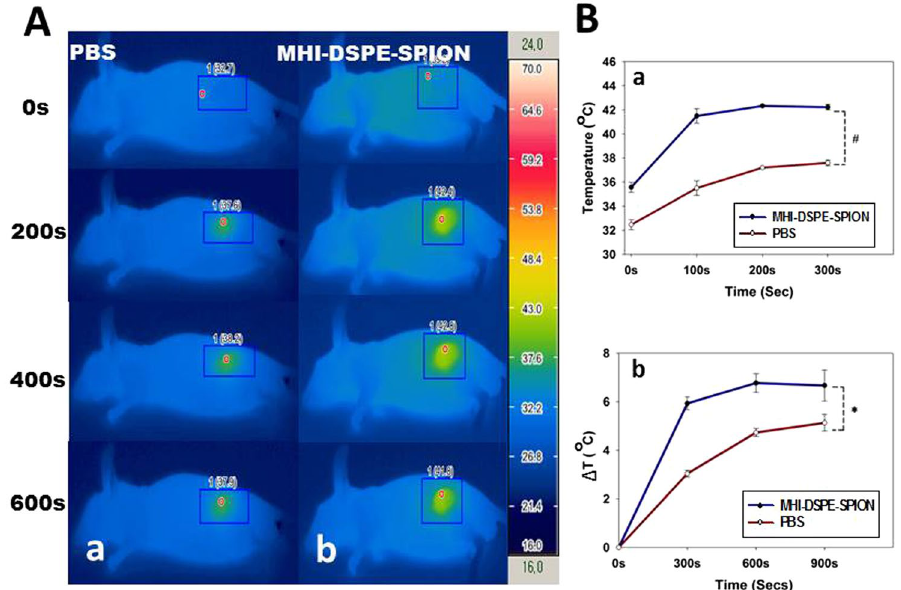
Figure 11. Temperature increase profiles in SCC7 tumor tissue after in vivo photothermal treatment. ( A ) Infrared photothermal images of mice measured after tail vein injection and laser irradiation. (a) Mice injected with 200 µ L PBS plus further laser irradiation, (b) Mice injected with 200 µ L MHI-DSPE-SPION at 10 mg[Fe]/kg concentration in PBS plus further laser irradiation. ( B ) (a) Maximum temperature profiles of SCC7 subcutaneous tumors after tail vein post-injection plus further laser irradiation and (b) Temperature change of tumor area upon laser irradiation. * P < 0.05 relative to PBS injected group (n =